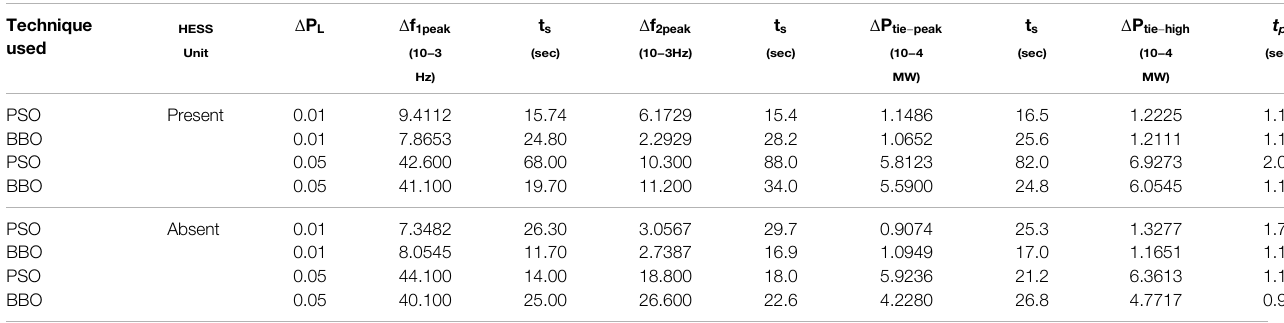
TABLE 1 | Performance analysis of the two-area interconnected system with HVDC link. Technique